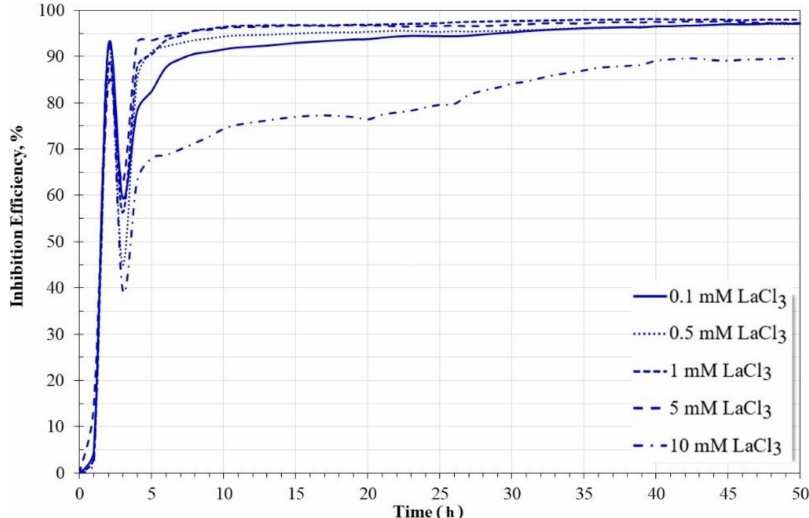
Figure 4. Effect of LaCl 3 concentration on inhibition efficiency.